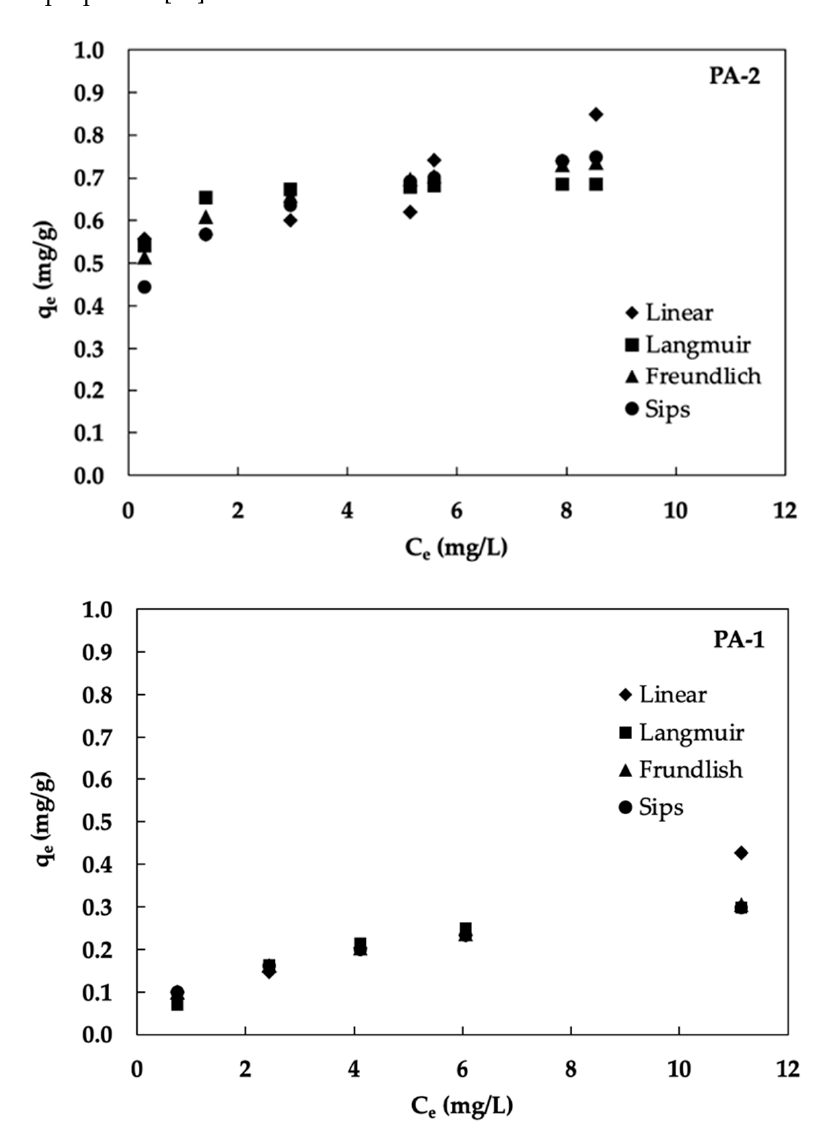
Figure 4. Adsorption isotherm of fluoride on PA-1 and PA-2 (pH 7, solid/liquid ratio 15 g/L, temperature 25 ◦ C, and vertical shaker at 200 rpm at equilibrium time). Table 5. Isotherm parameters of fluoride adsorption on PA-1 and PA-2 adsorbents.